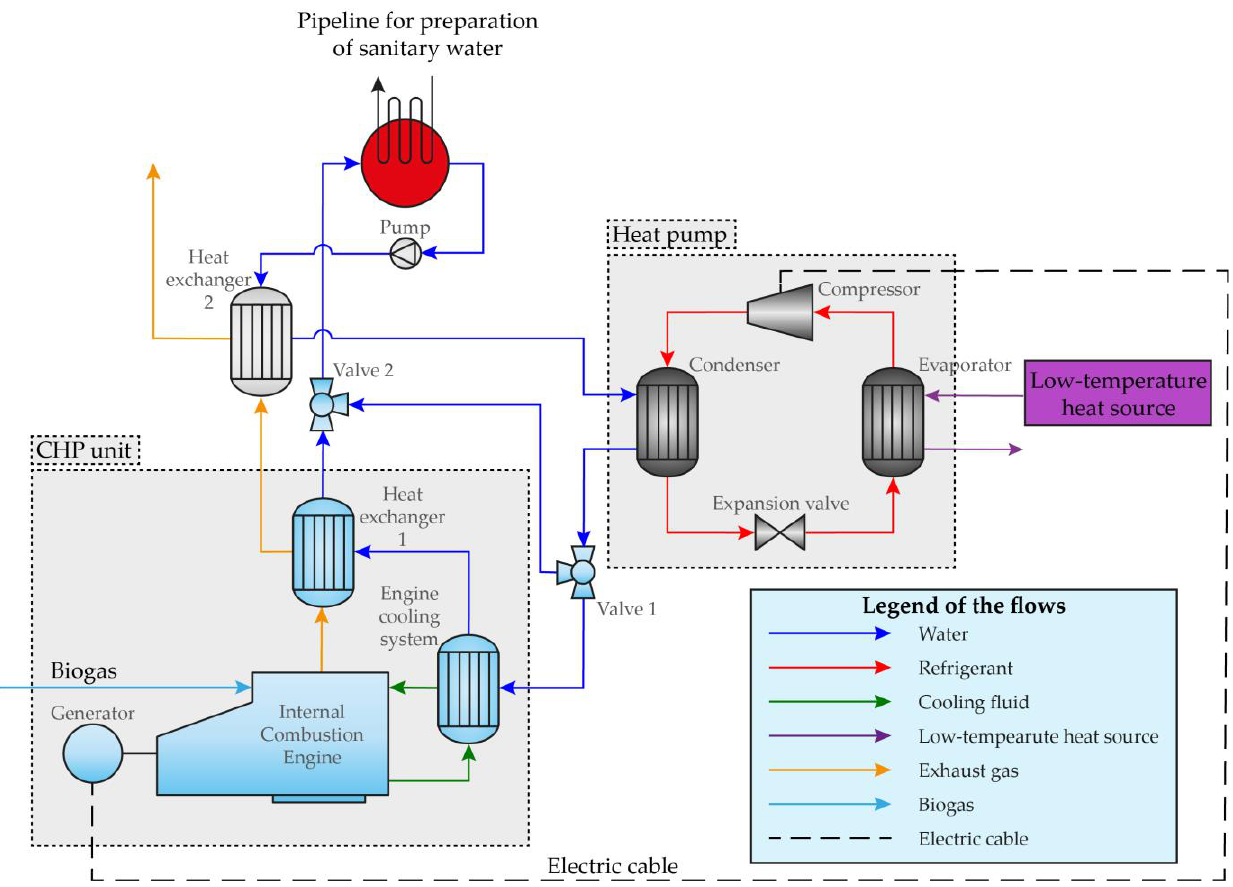
Figure 2. Scheme of a patented innovative technical solution for increasing the efficiency of the cogeneration power plant. Table 1. Technical data of CHP unit